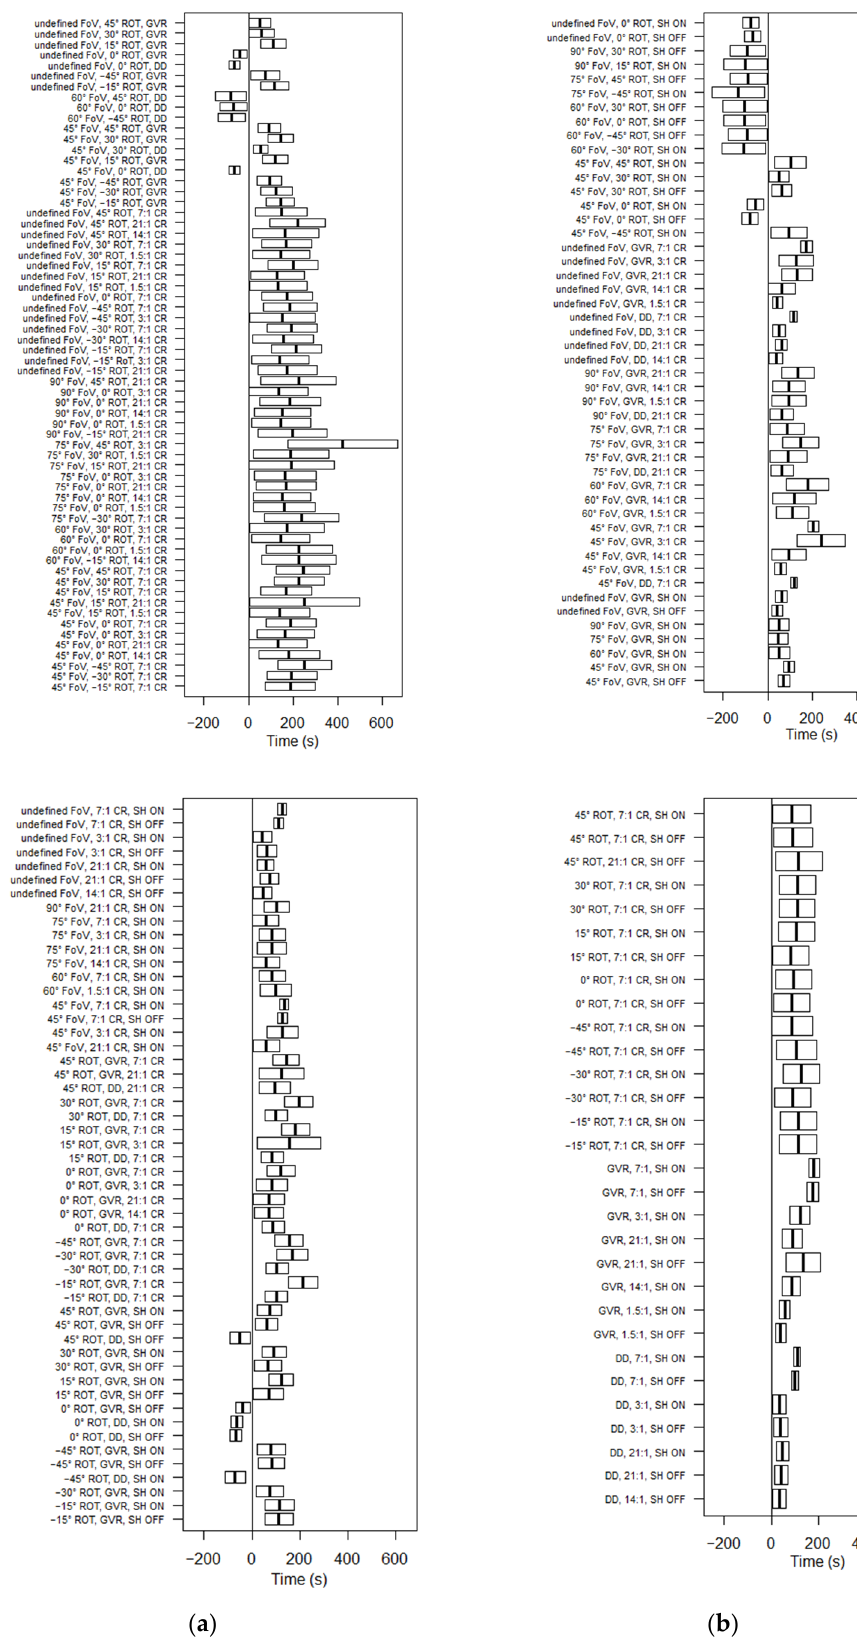
Figure 4. 95% CIs of each investigated significant triplet of factors, graphically split into ( a , b ) for better readability.